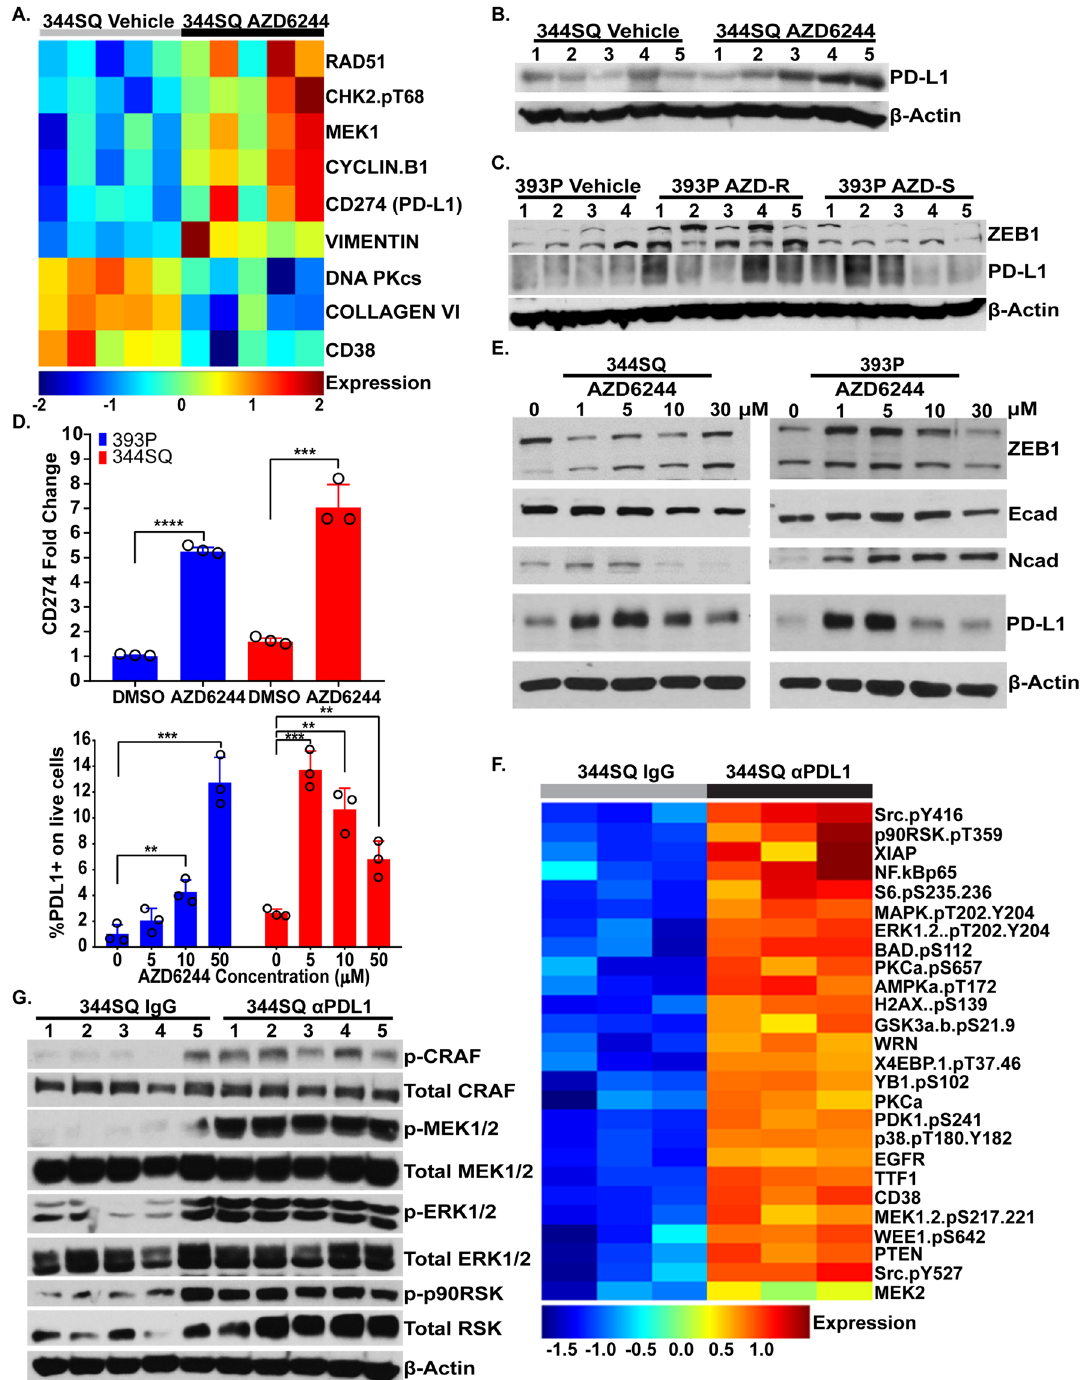
Fig. 1 MEK inhibition increases PD-L1 expression while PD-L1 blockade upregulates MAPK signaling. A Heatmap of reverse phase protein array (RPPA) pro fi le showing statistically signi fi cant (FDR < 0.05) differentially regulated proteins in 344SQ murine KP syngeneic tumors treated with selumetinib (AZD624) MEK inhibitor (black) or vehicle (grey) for 4 weeks. B Western blot of PD-L1 and β -actin in 344SQ tumors treated with vehicle or AZD6244 for 4 weeks. Number indicates tumor replicate. C Western blot of ZEB1, PD-L1, and β -actin in 393P tumors treated with AZD6244 for 4 weeks or 8 weeks when tumors were sensitive (AZD-S) or resistant (AZD-R) to MEK inhibition, respectively. Number indicates tumor replicate. D Top: qPCR analysis of CD274 (PD-L1) expression in 393P (blue) and 344SQ (red) cell lines treated with DMSO or 10 µ M AZD6244 for 48h. Bottom: percent of PD-L1 + 393P (blue) and 344SQ cells (red) analyzed by fl ow cytometry following treatment with indicated concentrations of AZD6244 for 48h. Data are presented as mean values ± SD. n = 3. Data were analyzed using unpaired Students t test. ** P < 0.01; *** P < 0.001; **** P < 0.0001. E Western blotting of indicated proteins in 393P and 344SQ cells treated with indicated concentrations of AZD6244 for 48h. F Heatmap of RPPA pro fi le showing statistically signi fi cant (FDR < 0.05) differentially regulated proteins in 344SQ tumors treated with PD-L1 blocking antibody (black) or IgG isotype control (grey) for 7 weeks. G Western blotting of indicated proteins of 344SQ tumors treated with IgG isotype control or PD-L1 blocking antibody for 7 weeks. Number indicates tumor replicate.